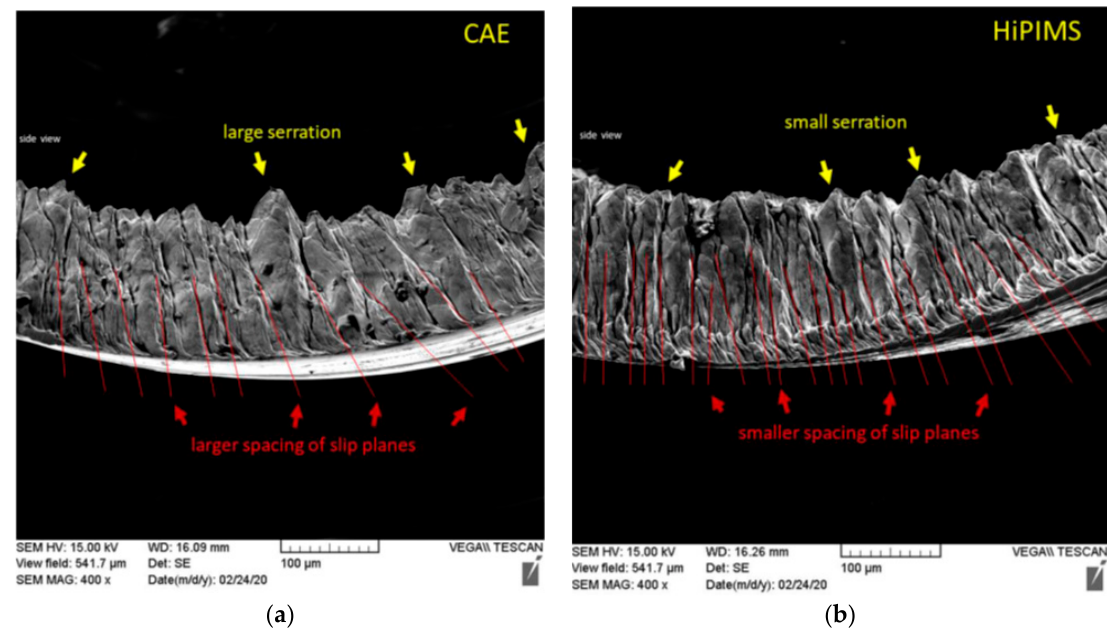
Figure 12. Chips upsurface produced by cutting tool with: ( a ) CAD and ( b ) HiPIMS coating.